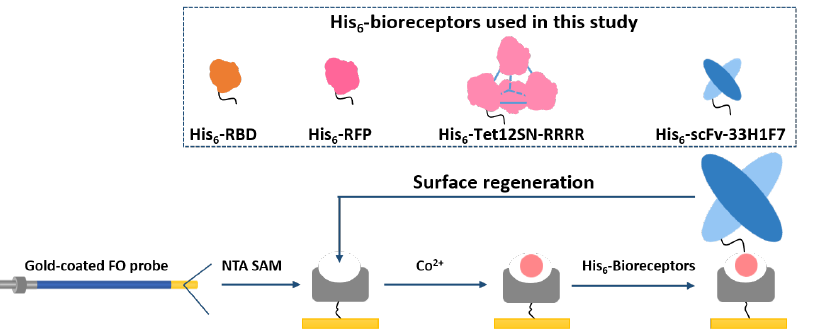
Figure 1. Schematic concept for the regeneration of cobalt (II)-nitrilotriacetic acid (NTA) surface on a gold-coated fiber-optic (FO) sensor probe by reversible removal/immobilization of His 6 -tagged bioreceptors. Four different model systems have been tested to verify the concept, including His 6 - tagged scFv-33H1F7, receptor-binding domain (RBD), red fluorescent protein (RFP) and Tet12SN- RRRR. scFv-33H1F7 has been depicted in the regeneration cycle as one of the